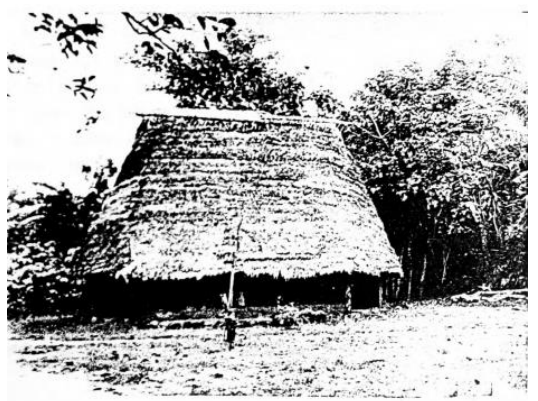
Figure 15 ii. Steeply Pitched Roofs Source: Nsude, 1987.